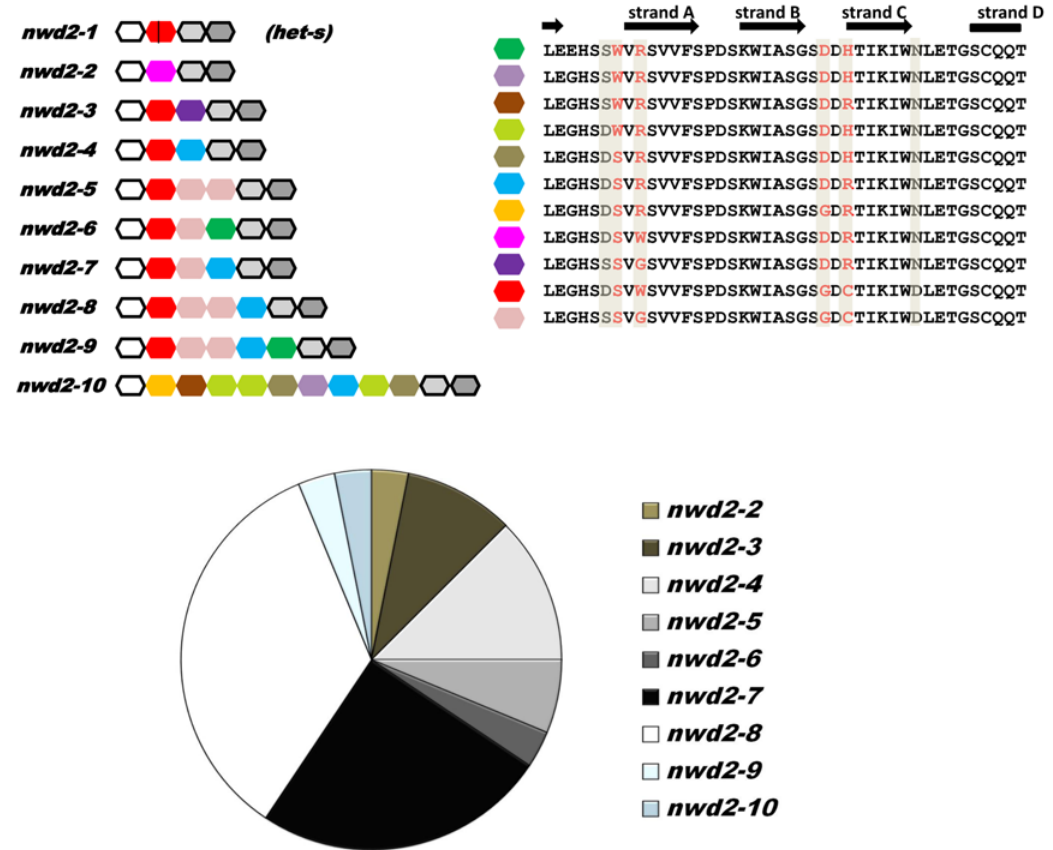
Fig 9. The NWD2 WD-domain is highly polymorphic in wild populations. A. Graphical representation of the WD-repeat domain of different nwd2 alleles identified in wild population from Wageningen. Each 42 amino acid WD-repeat is represented by a hexagonal box. The three fixed repeats common to all alleles are given in white, light and dark grey while the variable repeats are colored. The vertical bar in the second repeat of the nwd2 – 1 allele found in all het- s strains represents a stop codon. On the right, amino acid sequence of the different repeats are given, the four highly variable positions under positive diversifying selection are given in red and boxed in grey. Other polymorphic positions are boxed in grey. The secondary structure of each repeat is recall; variable loops at the WD-domain β -propeller binding surface are located between strand D and A, and B and C respectively. B. Pie chart of the nwd2 allele distribution in the 32 analyzed wild-type het-S